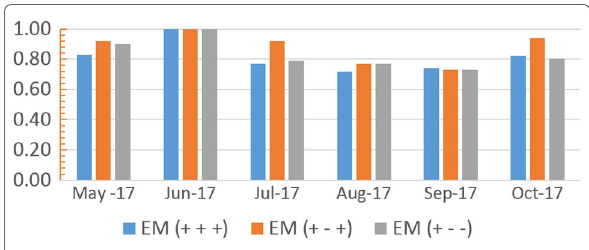
Fig. 7 F -Measure values for (+ + +) , (+ - +) , and (+ - -) cases for each tested month for the ME attack